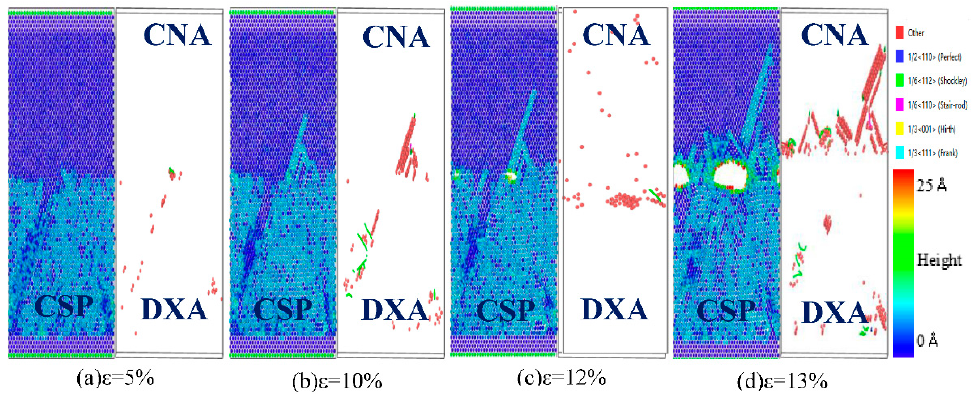
Figure 9. Atomic CSP, CNA, and DXA analysis of the Fe (100)/Cu (100) undiffused interface during z-axis tensile process.